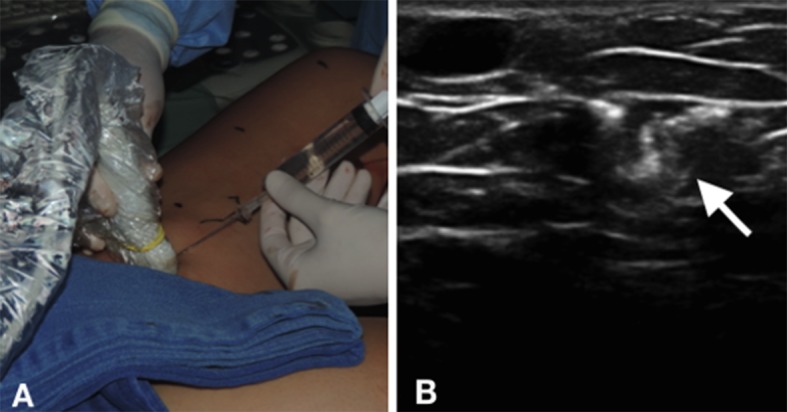
Infiltration with 0.9% saline (A) and echographic image after infiltration (B); Arrow: saphenous space after tumescence.